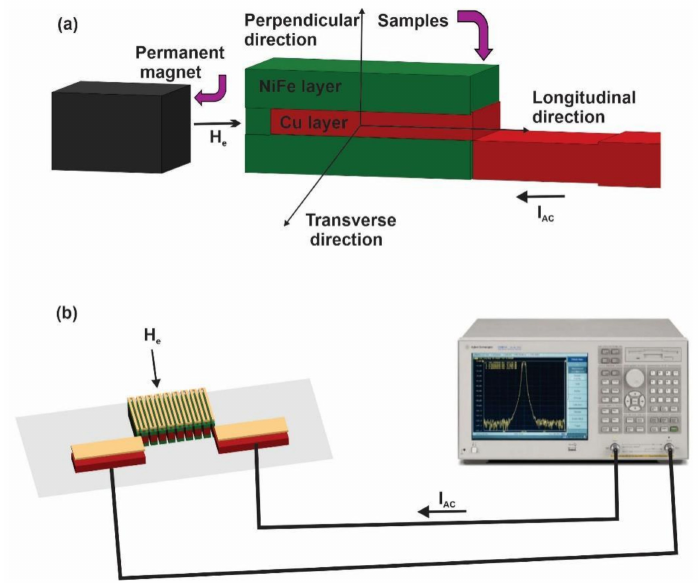
Figure 3. The experimental process and setup. ( a ) The magnetic field orientation; ( b ) the experimental